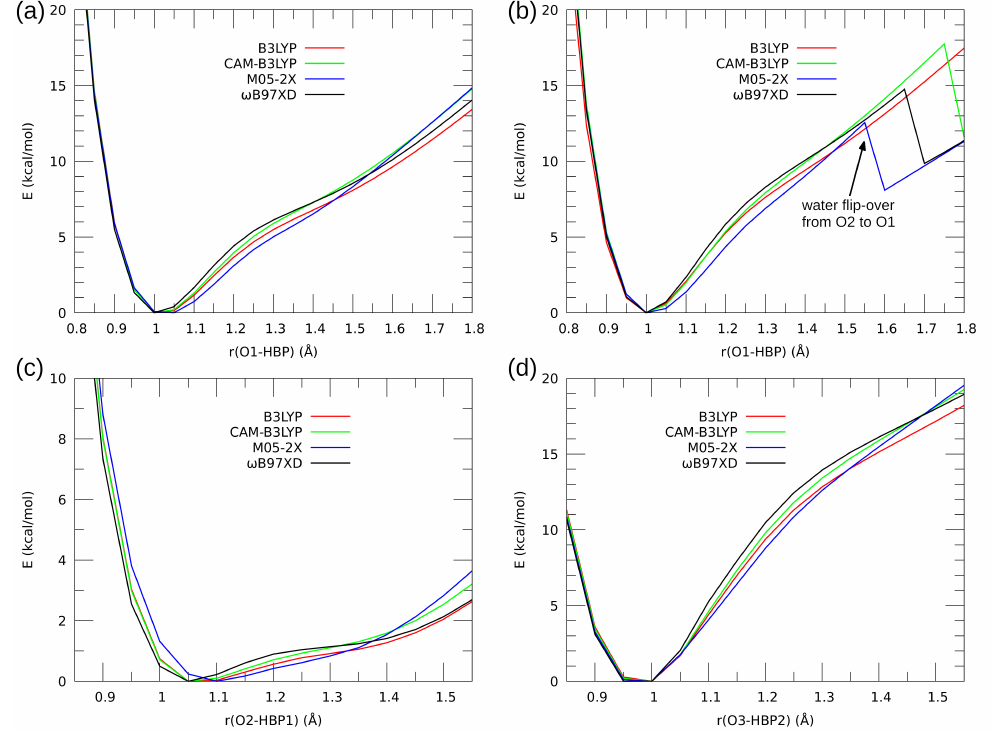
Figure 7. Proton potential profiles for the hydrogen bonds in the investigated systems—results of DFT relaxed scans. ( a ) compound 1 without water molecule; ( b ) compound 1 as monohydrate; ( c ) compound 2 —bridge O1. . .O2; ( d ) compound 2 —bridge O2. .